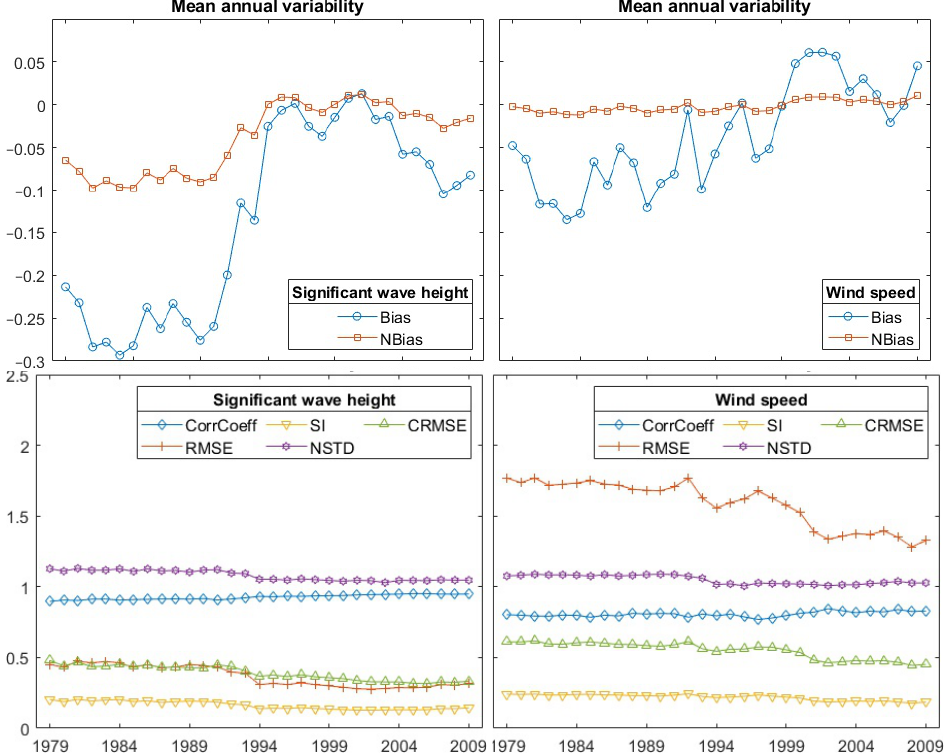
Figure 9. Mean annual variability of error measures between the two reanalyses ( left : significant wave height, right : wind